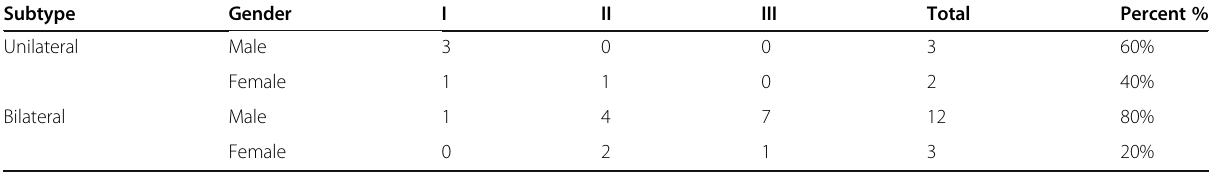
Table 1 The distribution of the SCP children according to SCP subtypes, gender, and the GMFCS levels Subtype